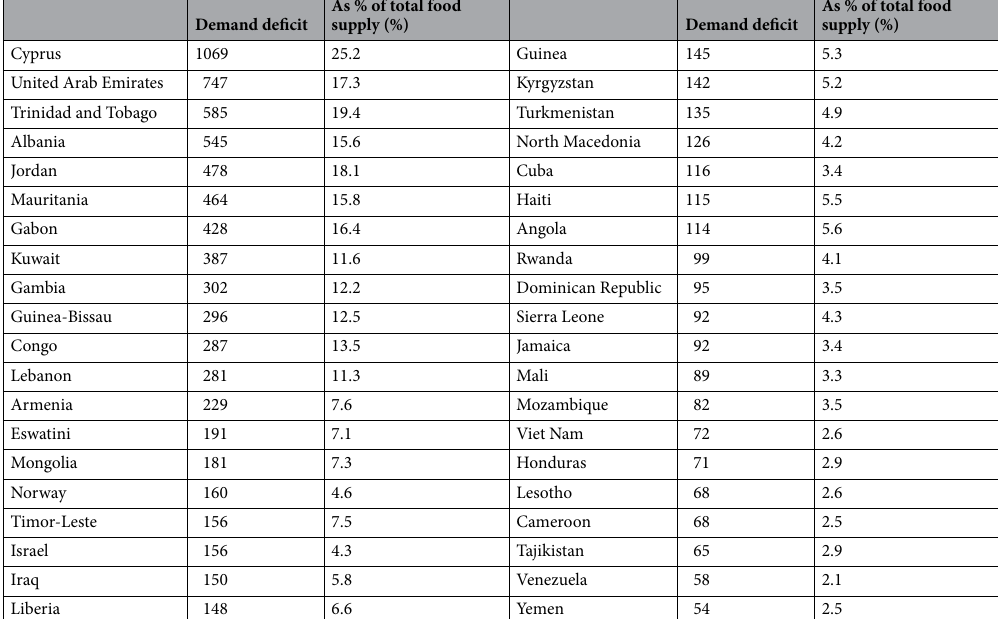
Table 1. Demand deficits in worst-case scenarios. The table reports the countries which, in a worst-case scenario, experience the highest demand deficit in terms of kcal/person/day. The overall demand deficit is also reported as a percentage of total domestic food supply. The worst-case scenarios are identified by taking the 95th percentile (reported in terms of kcal/person/day) of the distribution of country-level demand deficits. The distribution of the country-level demand deficits pools the deficits resulting from three sets of simulations based on different values of the α parameter ( α = 0, 0.5, 1 ). The list includes only countries with a population of at least one